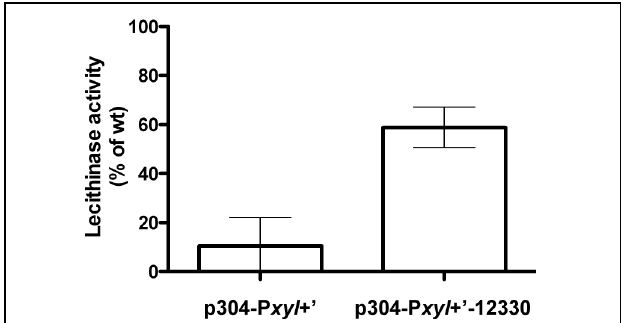
FIGURE 7 | Lecithinase activity of (cid:2) codY cells overexpressing oppA in the presence of synthetic PapR peptide. (cid:2) codY cells harbor the empty p304-P xyl + ’ vector or express the oppA gene under the control of the P xyl + promoter (p304-P xyl + ’-12330). The cultures were split 0.5 h before the transition into stationary phase (t-0.5) and the synthetic peptide PapR7 was added at a final concentration of 5 μ M. Cells were grown in LB supplemented with xylose at 37 ◦ C. Samples were collected for lecithinase assay 2.5 h after addition of the peptide. The sequence of the peptide is indicated in Section “Materials and Methods.” The results are the mean values of two independent experiments, and the error bars represent standard deviation.